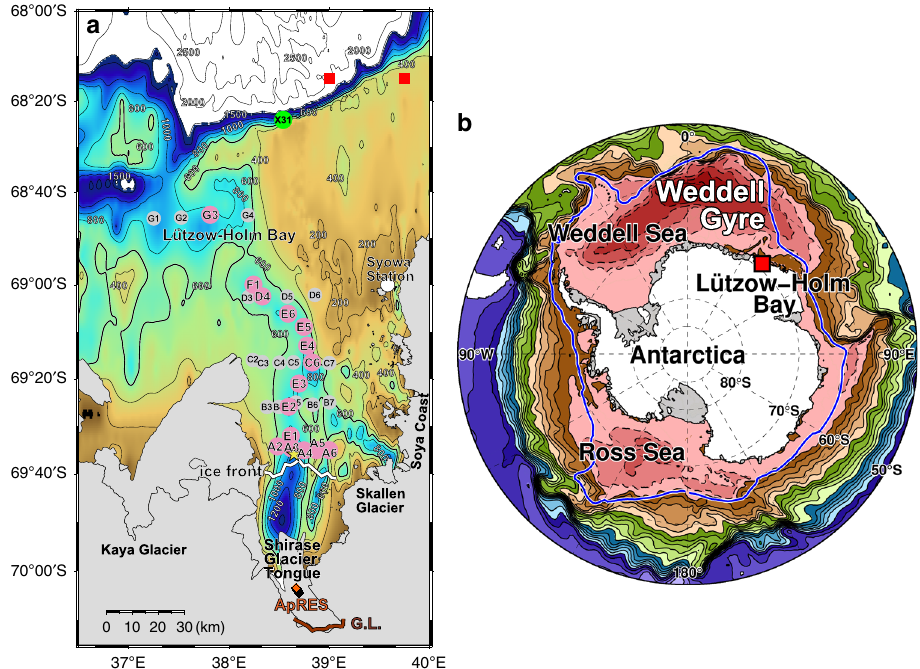
Fig. 1 Study area of Lützow-Holm Bay, East Antarctica. a Bathymetry in and around Lützow-Holm Bay, where the domain is indicated by red rectangular in b . Pink and gray circles represent positions of CTD stations, and the pink-colored stations are used for vertical sections along (Fig. 2a – c) and across (Fig. 2d, e) the deep trough. Green circle indicates the position of a XCTD cast (Sta.X31) at the northeast continental slope region of the bay. Yellow star near Sta.A3 represents the position of a subsurface mooring with a current pro fi ler, running from late January to August in 1990 (the same position as Sta. P2, see Supplementary Fig. 2). Red squares represent grid locations of wind reanalysis at 10 m height provided by the European Centre for Medium-Range Weather Forecasts (ECMWF) Interim Re-Analysis (ERA-Interim). Orange diamonds indicate positions of ice radar ApRES deployed on the SGT from February 2018 to January 2019. Thick white line shows the SGT ice front derived from MODIS imagery on 22 January 2017, which is different from a model ’ s ice front position (see Supplementary Fig. 6). Thick brown line represents the SGT grounding line 71 . b Simulated annual mean vertically integrated transport stream functions 32 . Red colors with dashed contours indicate cyclonic circulation. Contour interval is 10 Sv (1 Sv = 1.0 × 10 6 m 3 s − 1 ). Thick blue line shows the southern boundary of the ACC 6